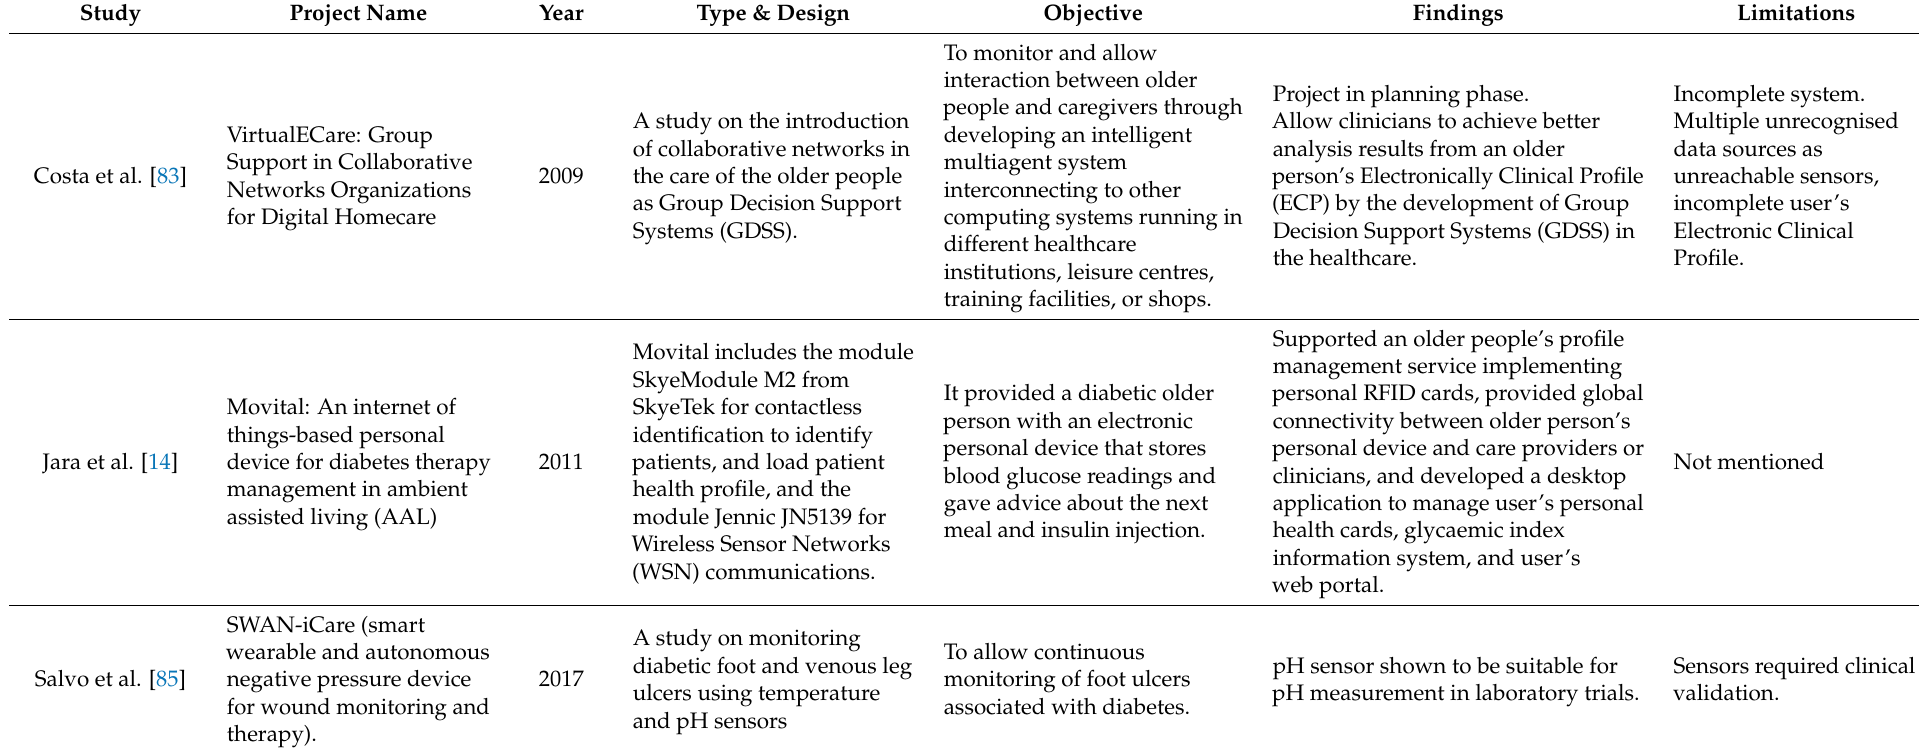
Table 5. ICT solutions for assistive living of older people with diabetes